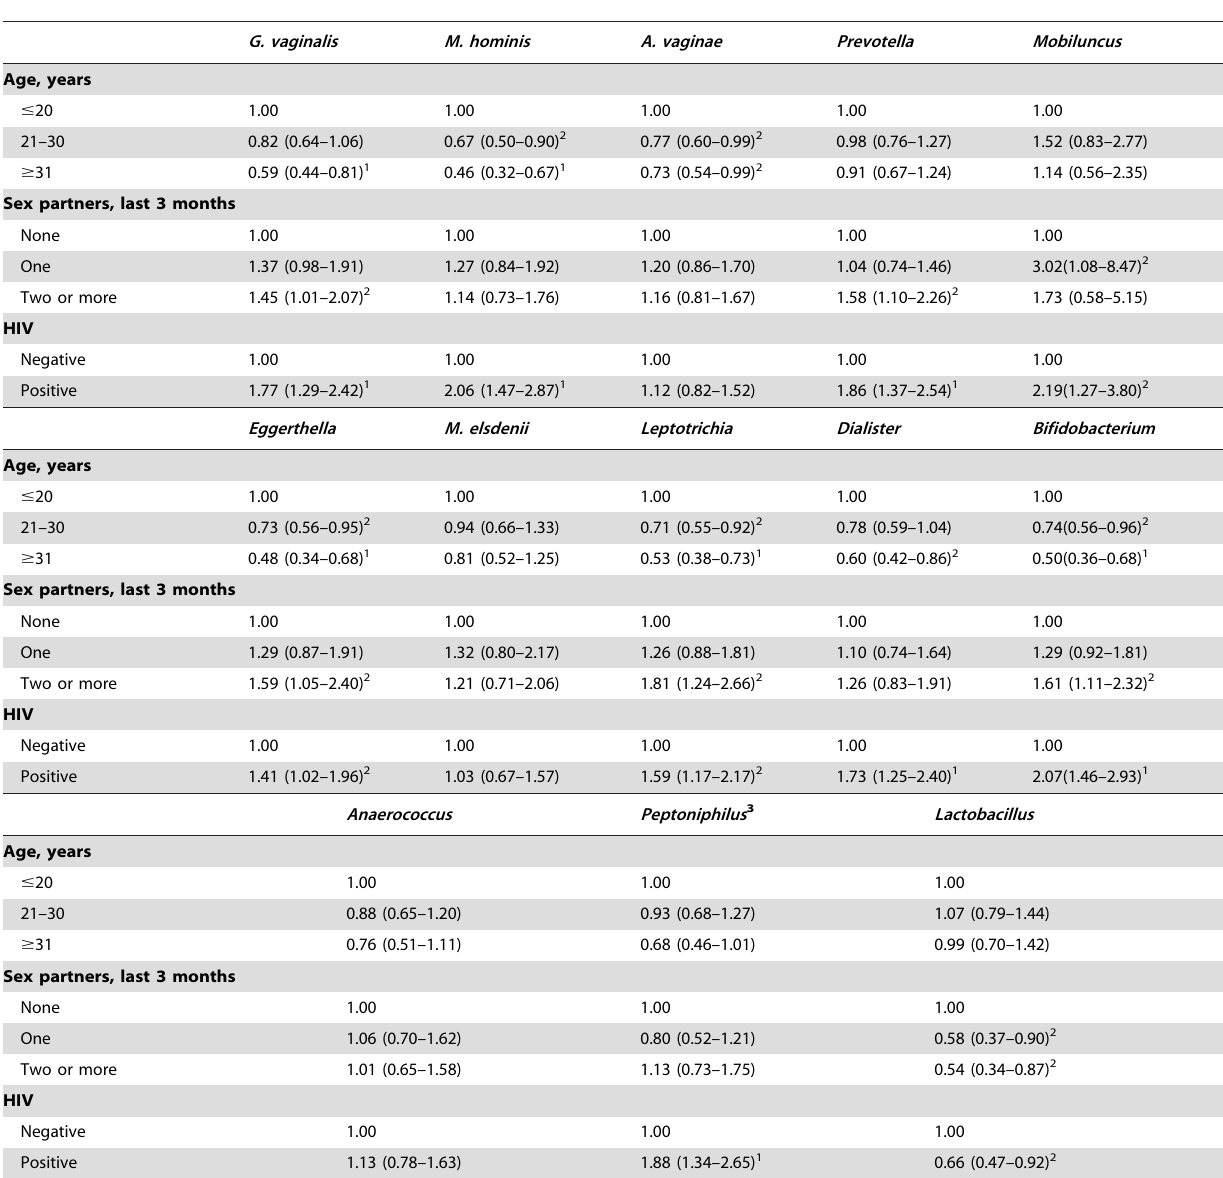
Table 2. Correlates of colonization/infection with various bacterial genera or